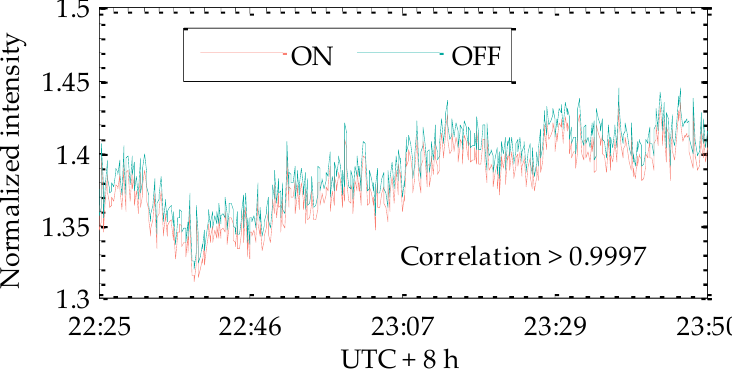
Figure 14. Integration paths for IPDA lidar testing. The orange double arrow line is the 580 m horizontal path. The red double arrow line is the 1.5 km horizontal path. The base map comes from the China National Platform for Common Geospatial Information Services (http://www.tianditu.gov.cn/).